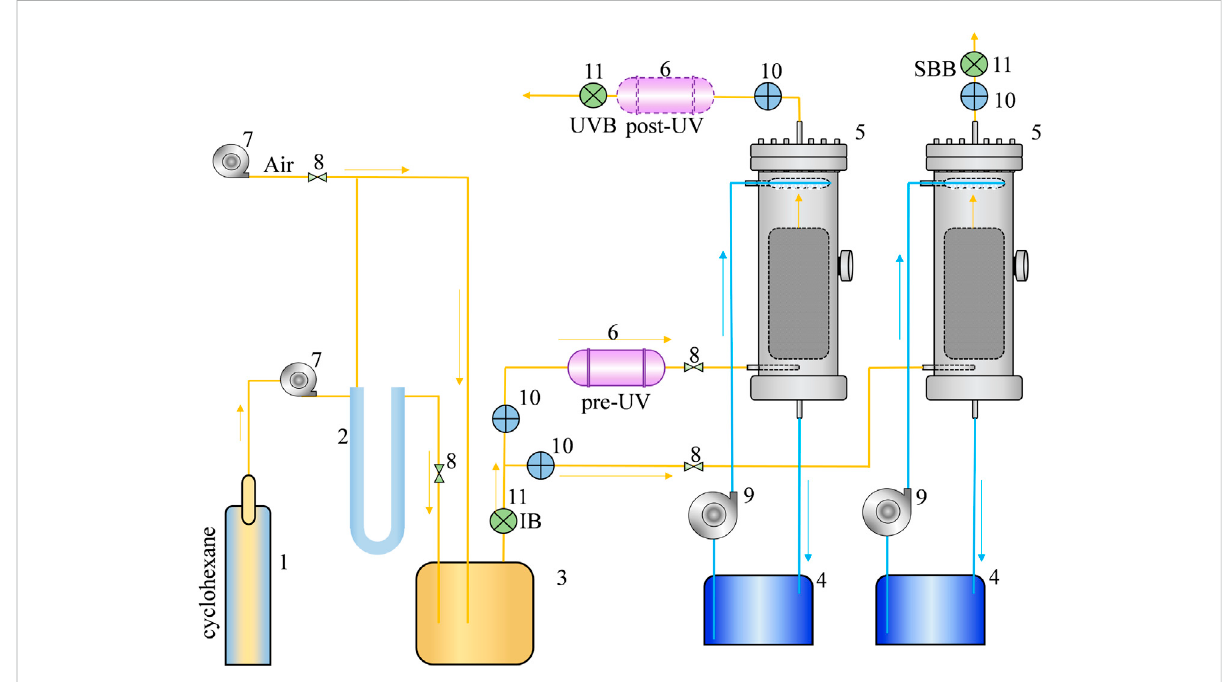
FIGURE 1 Schematicdiagramofthebio-trickling fi lter(1.cyclohexanereagent;2. U-tube;3.airmixedtank;4.nutrienttank;5.BTF;6.UVphotoreactor; 7. air pump; 8. rotameter; 9. circulating pump; 10. sampling port; 11. bioaerosols sampling